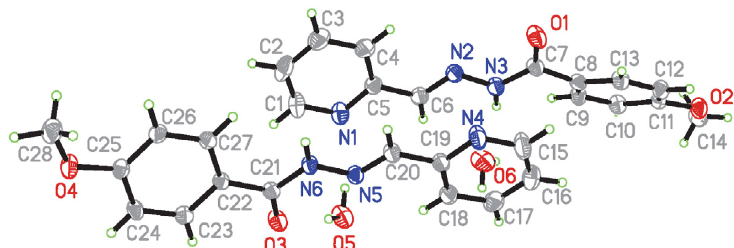
Figure 1. Molecular structure of HL 2 , showing the atom-numbering scheme. Displacement ellipsoids for non-hydrogen atoms are drawn at 30% probability